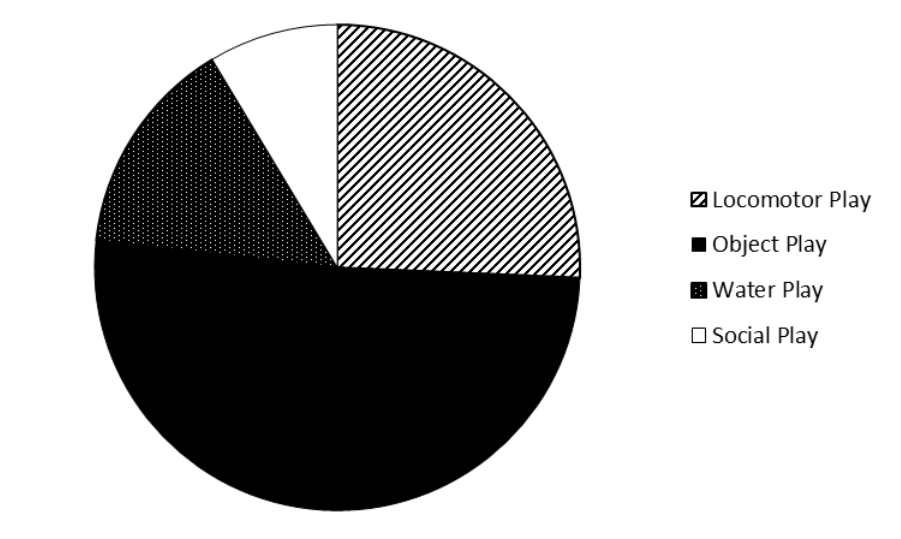
Figure 2. Percent of type of play